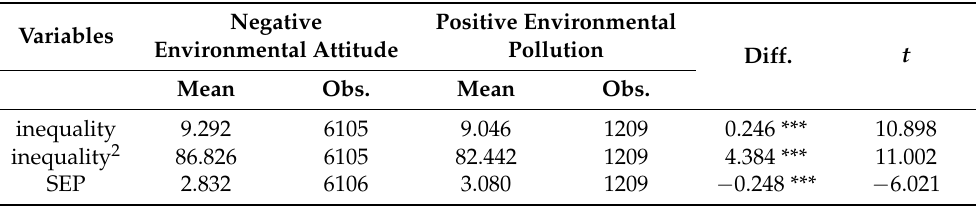
Table 12. t test of individual-level income inequality and subjective environmental pollution: differ- ences in environmental attitude.